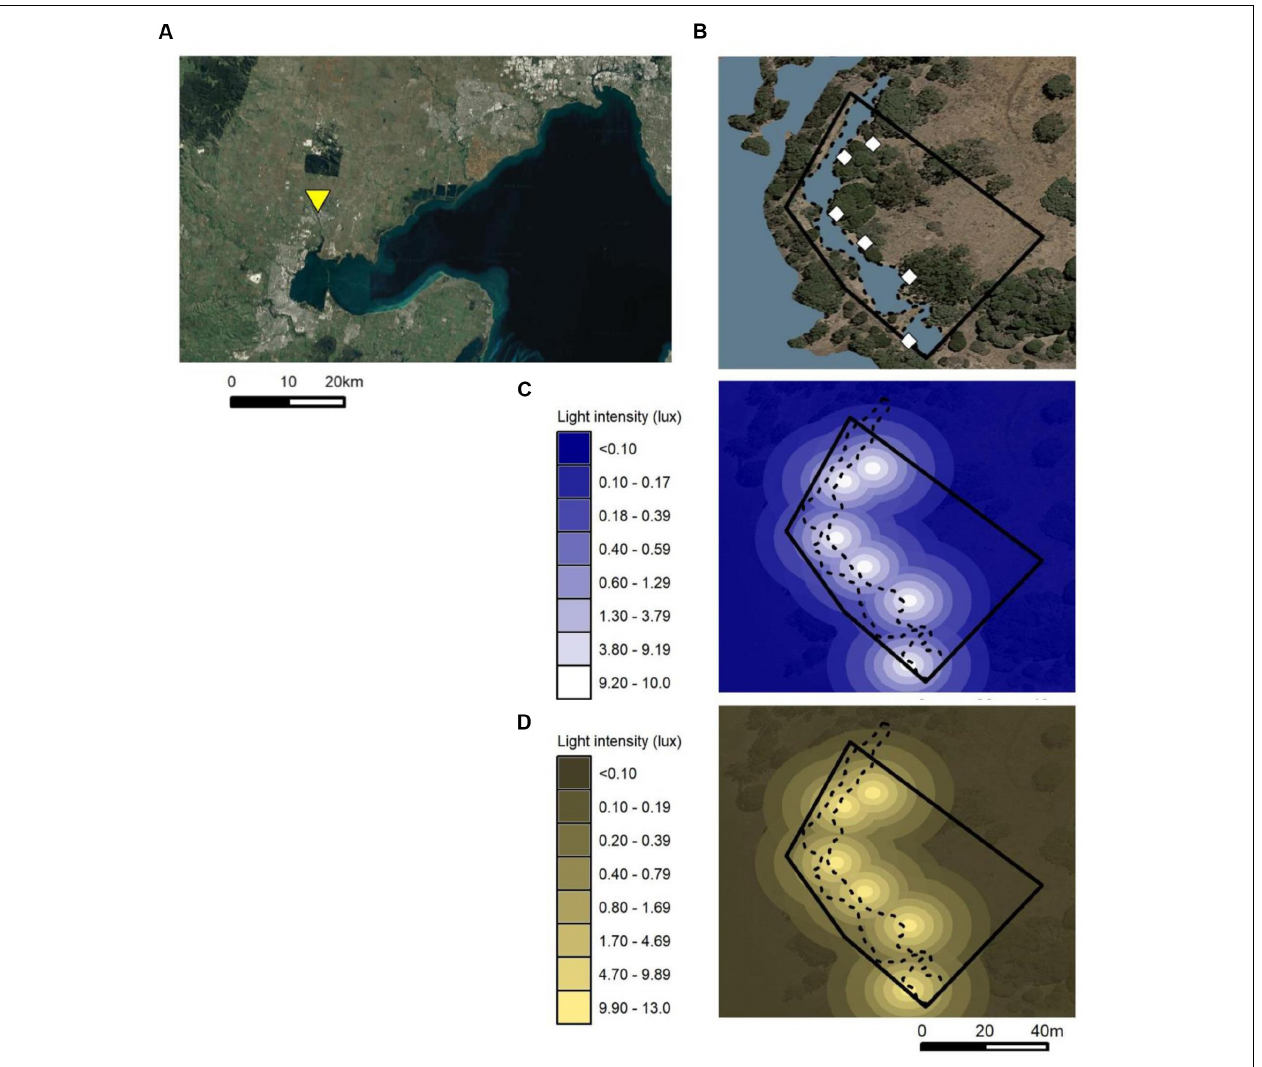
FIGURE 1 | Maps of swan enclosure. (A) Map showing location of swan enclosure at Serendip Sanctuary, Lara (38 ◦ 0 (cid:48) S, 144 ◦ 24 (cid:48) E; yellow triangle) to the south-west of Melbourne (at the northern end of Port Phillip Bay); (B) satellite image showing vegetation, ponds (blue), outer fence (solid black line), and positions of streetlights (white diamonds); (C) light intensity with distance from light poles during the white light treatment, and (D) during the amber light treatment. Light intensity values do not account for shielding provided by vegetation. Light intensity was measured at ground level facing the light pole using an SKL 30046473 lux meter with sensor SKL 310L 46472 (Skye Instruments, Llandrindod Wells, United Kingdom) on a single night. When facing away from the light, light intensity was similar to moonlight ( < 0.05 lux) 11 m away from the light pole. Maps were generated using Google Earth and ggmap (Kahle and Wickham,